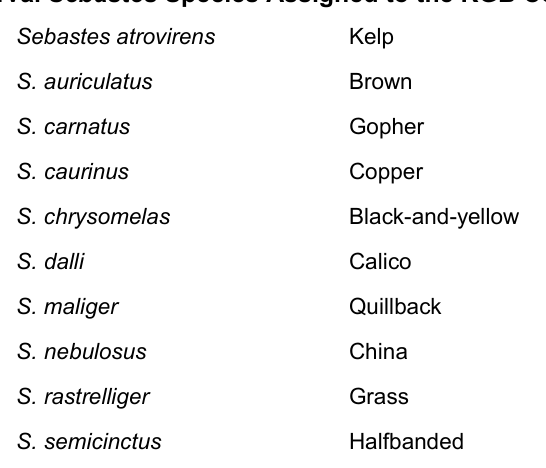
Larval Sebastes Species Assigned to the KGB